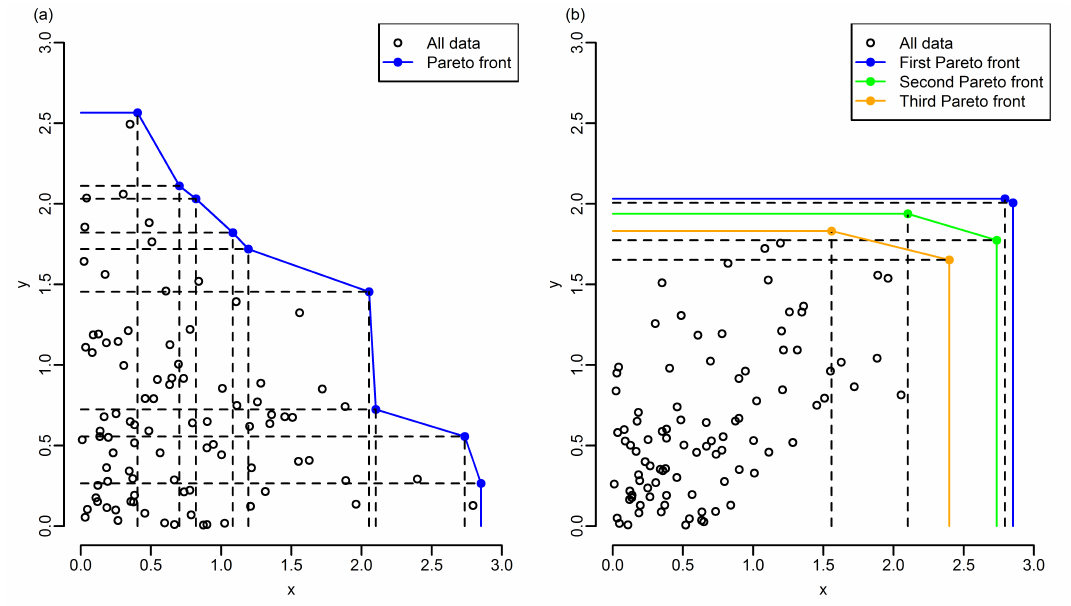
Figure 3. Illustration of Pareto optimality. ( a ) Samples from two independent Gaussian distributions. The Pareto front consists of the blue points. The broken lines show the regions of the space that are dominated by each Pareto-optimal point. ( b ) Samples from two strongly-correlated Gaussian distributions. A number of higher-order Pareto fronts are indicated as well (see the text for